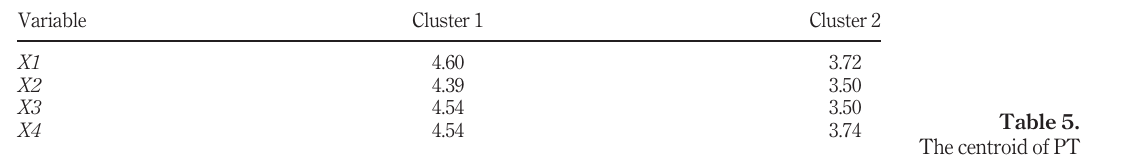
Table 5. The centroid of PT pelindo I